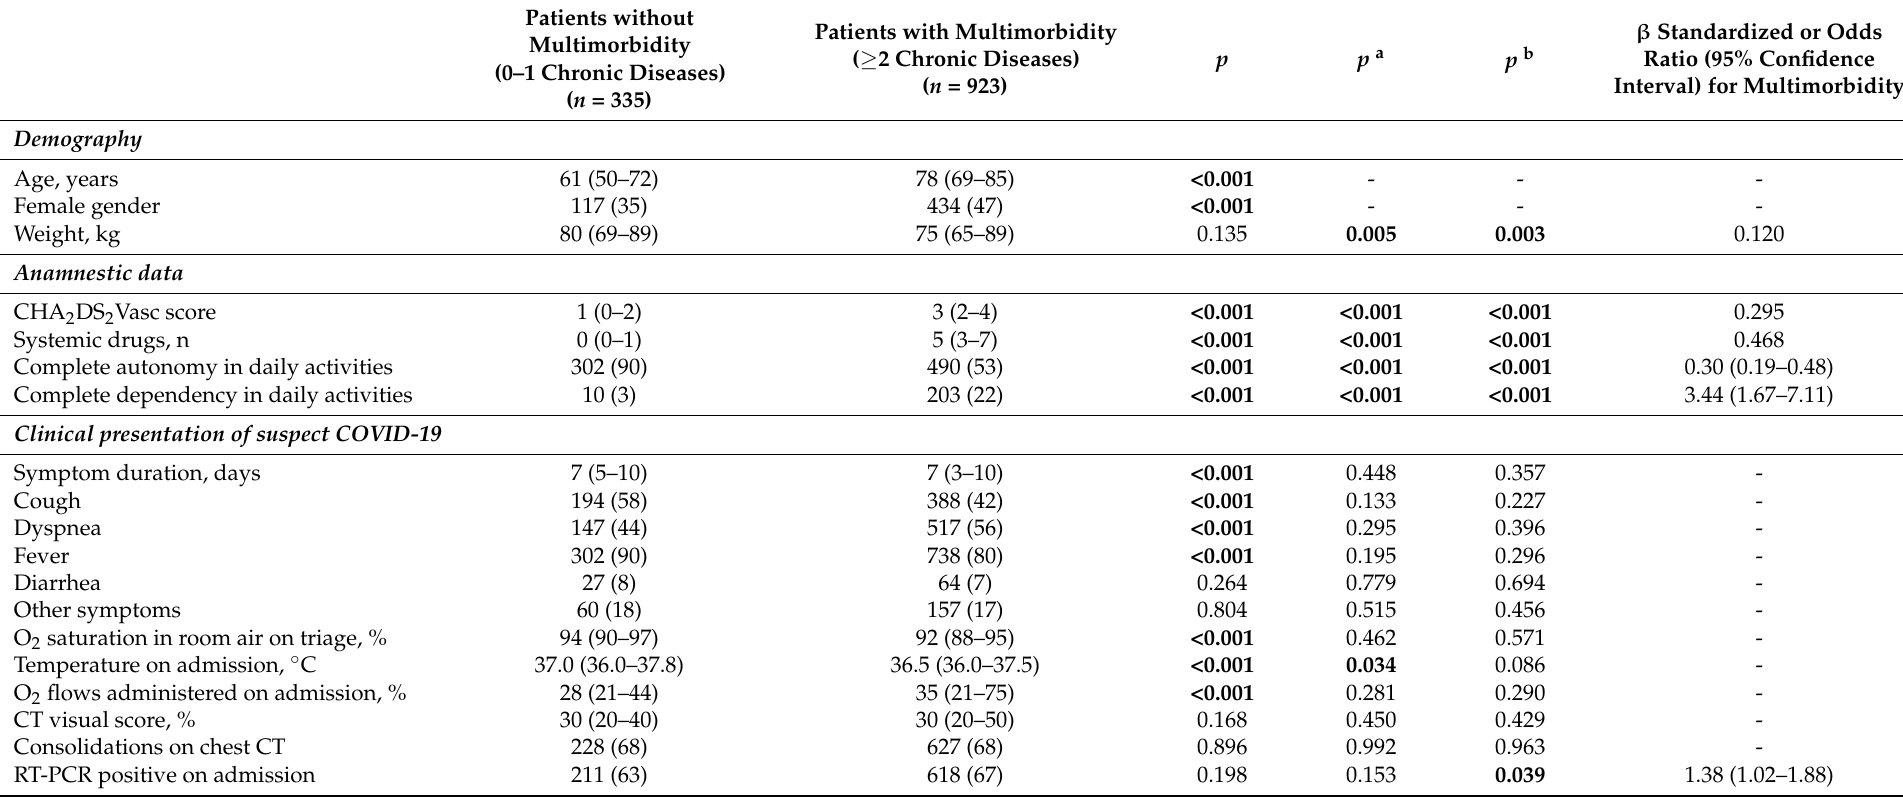
Table 4. Comparison of the demographic, anamnestic and clinical features of patients categorized according to the presence of